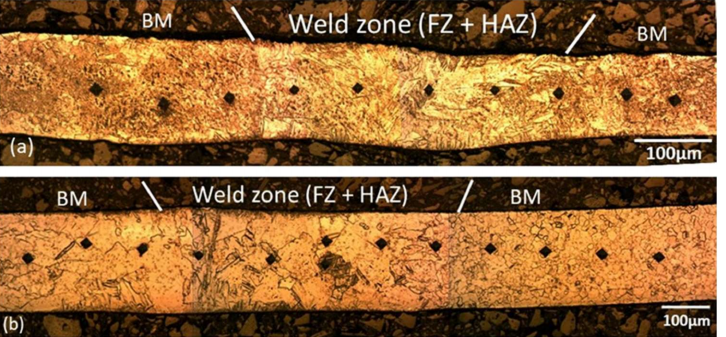
Figure 6. Hardness indentations on metallographically prepared samples: ( a ) 100 µ m and ( b ) 200 µ m thick foil samples.